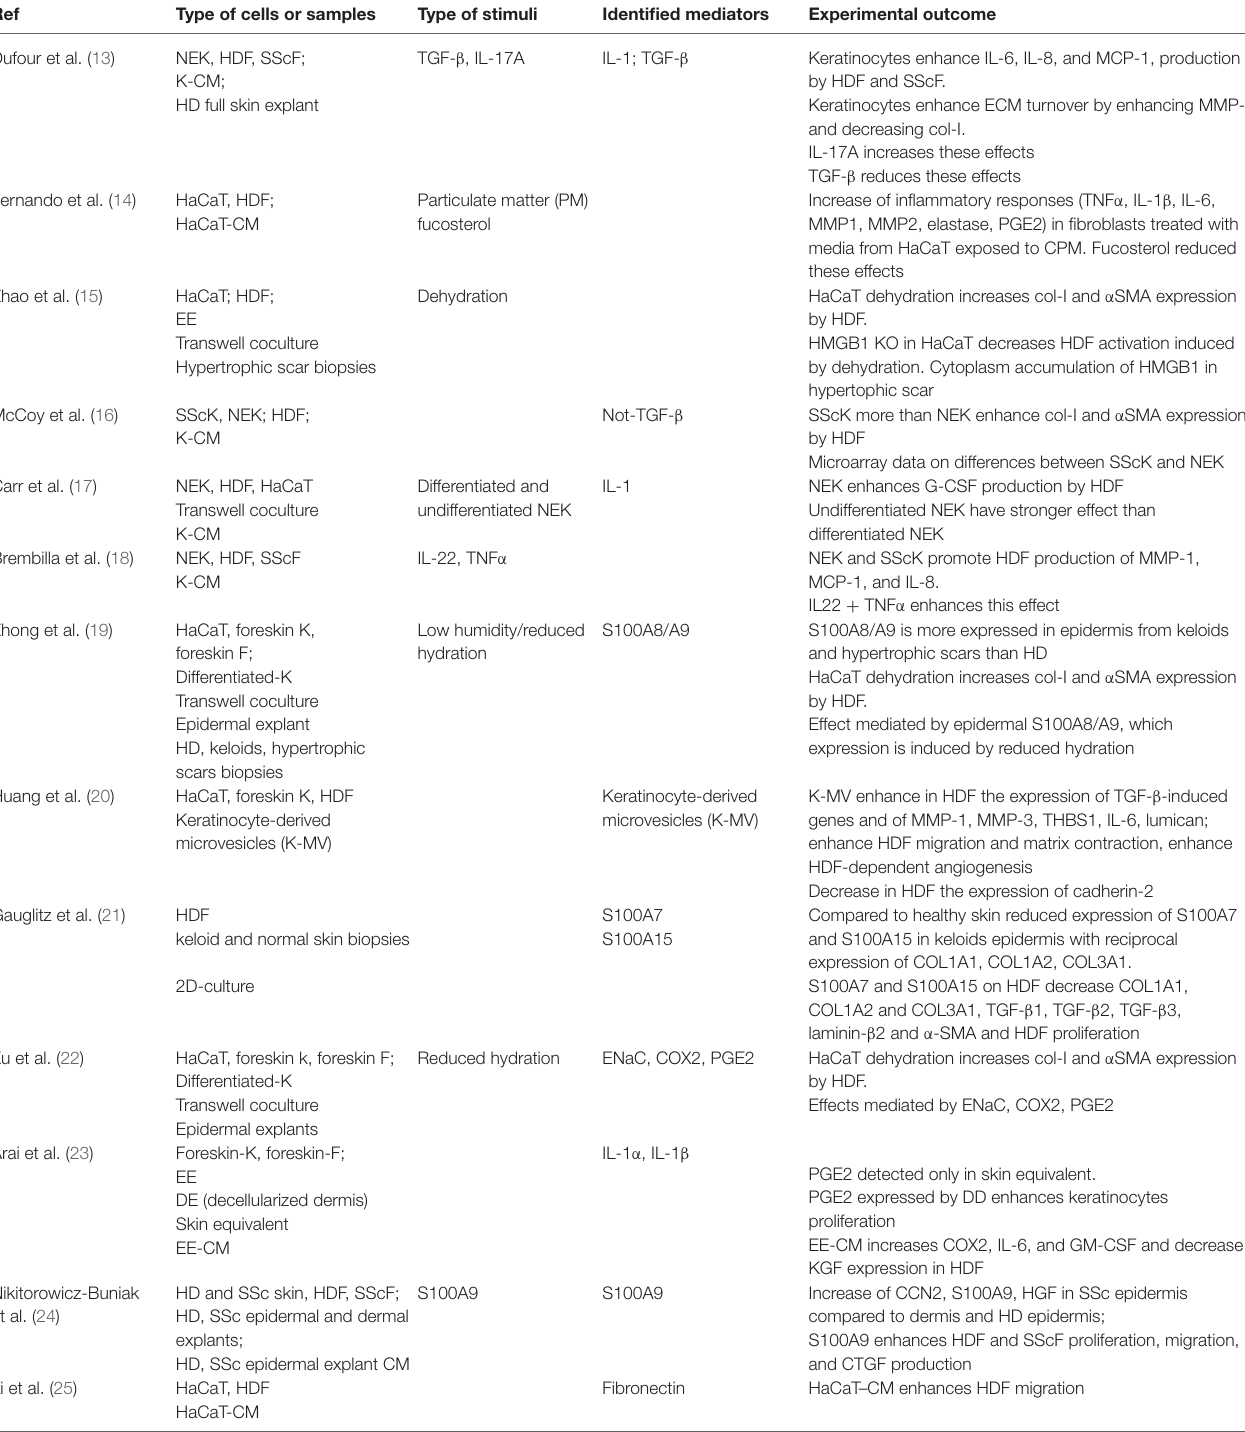
TABLE 1 | In vitro and ex vivo studies on the effect of human keratinocytes on dermal fibroblasts.